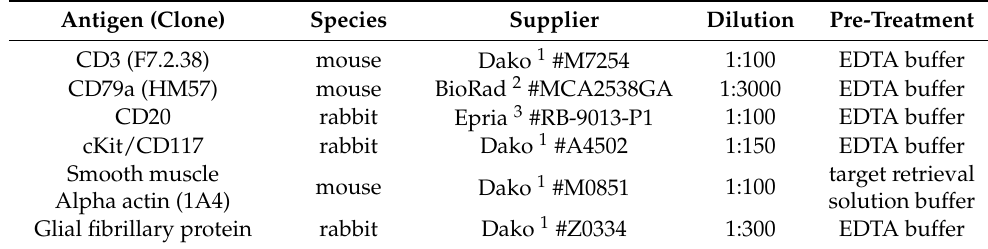
Table 1. Primary antibodies and pre-treatment used in routine immunohistochemistry in this study. Antigen (Clone) Species Supplier Dilution